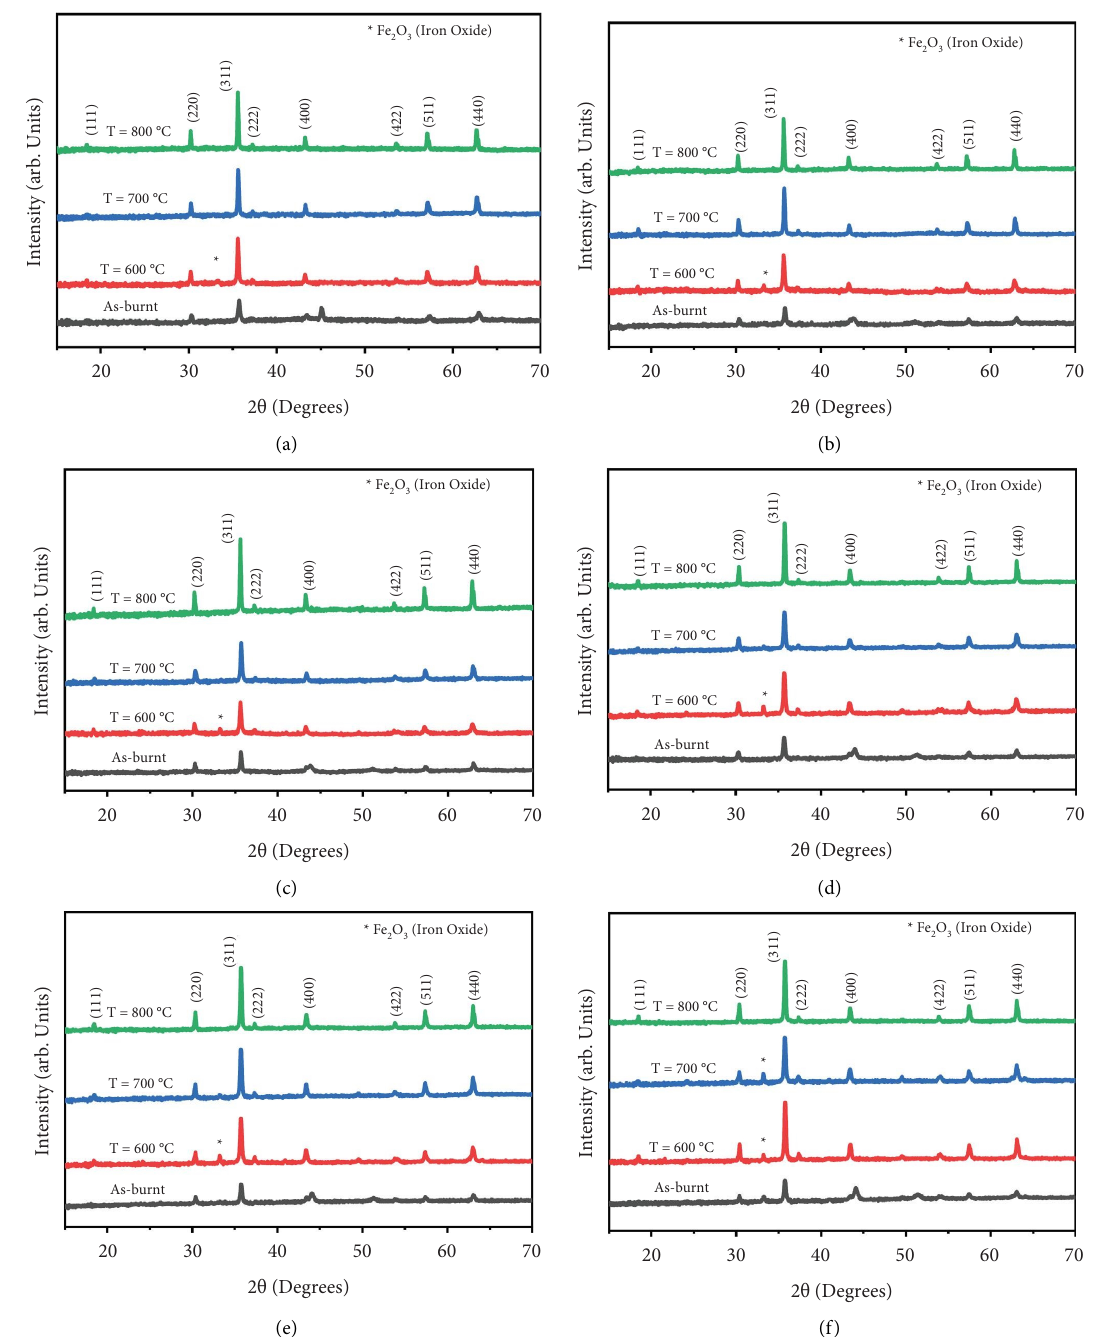
2 O 4 , (b) Co 0.8 Ni 0.2 Fe 2 O 4 , (c) Co 0.6 Ni 0.4 Fe 2 O 4 , (d) Co 0.4 Ni 0.6 Fe 2 O 4 ,